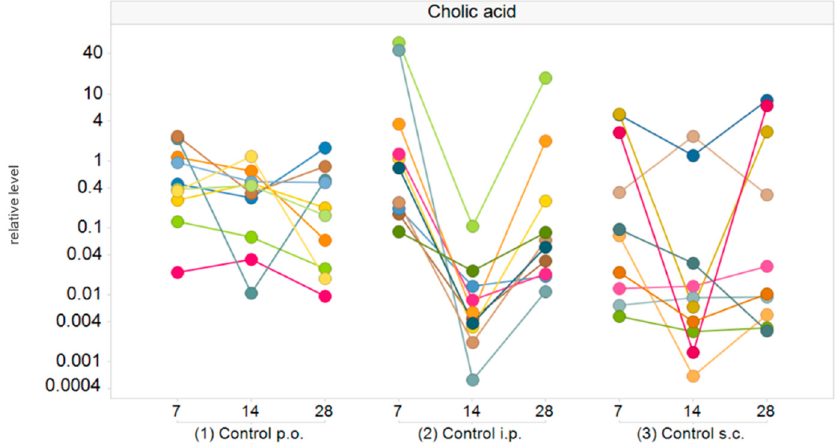
Figure 5. Relative cholic acid levels (normalized to the median value of the feeding controls) in plasma of male Crl/Wi(Han) rats in the different control groups ( n = 10 per group) on days 7, 14 and 28. Values from the same animals are connected. p.o., per os (by mouth); i.p., intraperitoneal; s.c., subcutaneous.